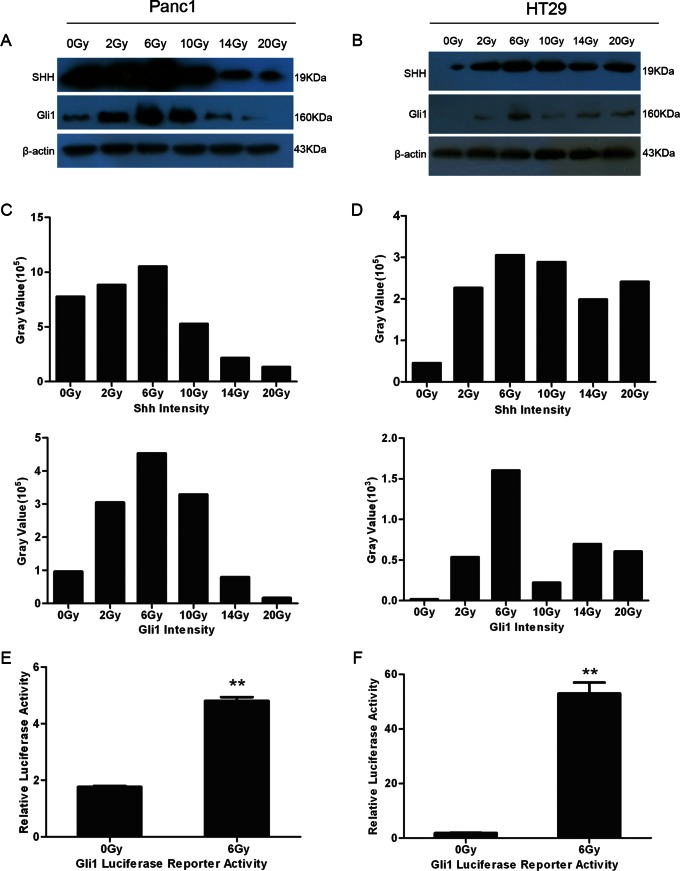
Evidence for SHH signaling pathway activation in irradiated Panc1 and HT29 cells.A. Expression-profile changes of Shh and Gli1 proteins in Panc1 cells irradiated at various doses and detected by Western blot. B. Expression-profile changes of Shh and Gli1 proteins in HT29 cells irradiated at various doses and detected by Western blot. C. Relative intensity of Shh and Gli1 protein bands on Western blot in Panc1 cells irradiated at various doses. D. Relative intensity of Shh and Gli1 protein bands on Western blot in HT29 cells irradiated at various doses. E. Luciferase activity of Gli1 reporter in irradiated and non-irradiated Panc1 cells. **represents P<0.01. F. Luciferase activity of Gli1 reporter in irradiated and non-irradiated HT29 cells. **represents P<0.01.